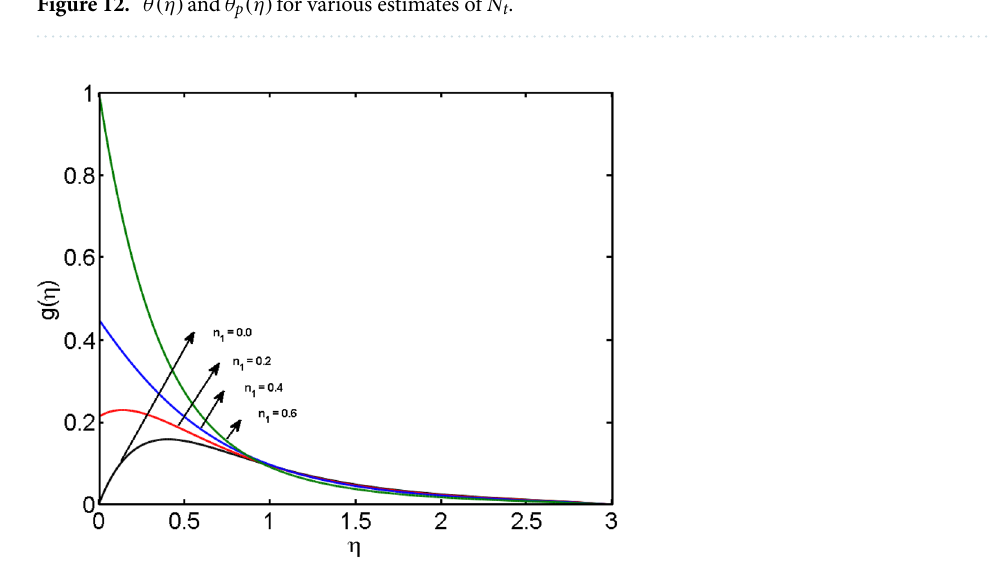
Figure 12. θ(η) and θ p (η) for various estimates of N t .